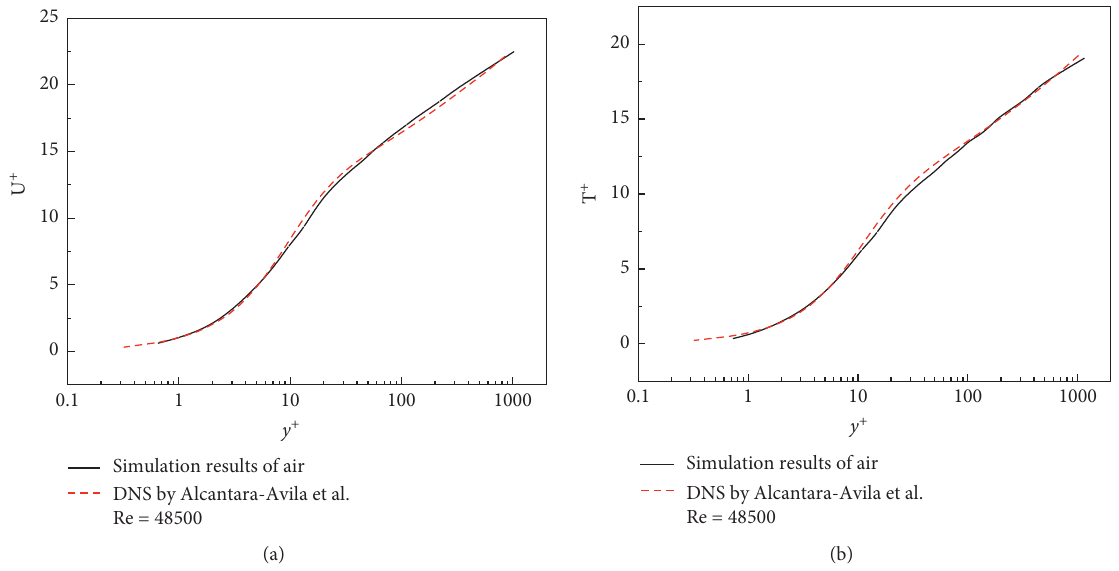
Figure 7: Comparison of air numerical simulations and DNS results. (a) Profile of air velocity and (b) profile of air temperature.